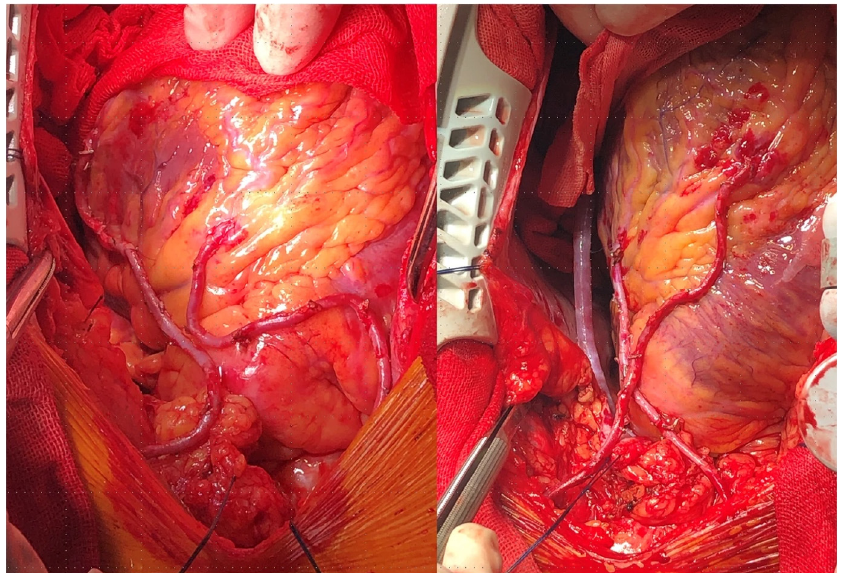
Figure 1. ( Left ) panel: In ‐ situ right internal thoracic artery to left anterior descending artery with in ‐ situ left internal thoracic artery to the diagonal branch. ( Right ) panel: In ‐ situ right internal thoracic artery to left circumflex branch with in ‐ situ left internal thoracic artery to left anterior descending. (Reproduced without changes from: “Application of bilateral internal mammary artery with differ ‐ ent configurations in coronary artery bypass grafting” by Han et al.; Journal of Cardiothoracic Sur ‐ gery, 2021; License: CC BY 4.0, https://creativecommons.org/licenses/by/4.0/, accessed on 15 January 2023).